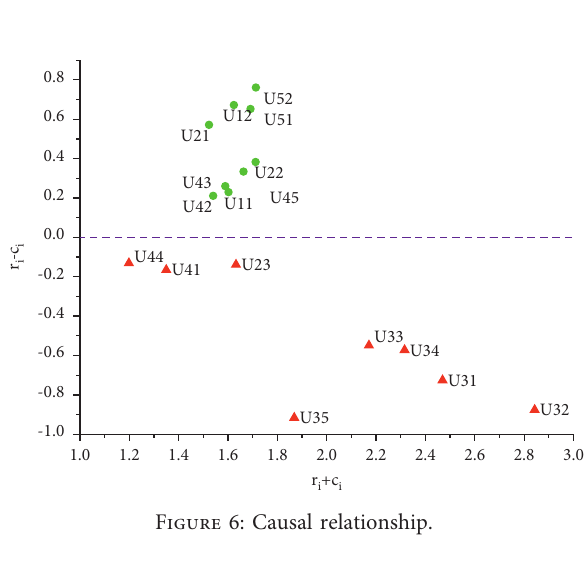
Figure 6: Causal relationship.